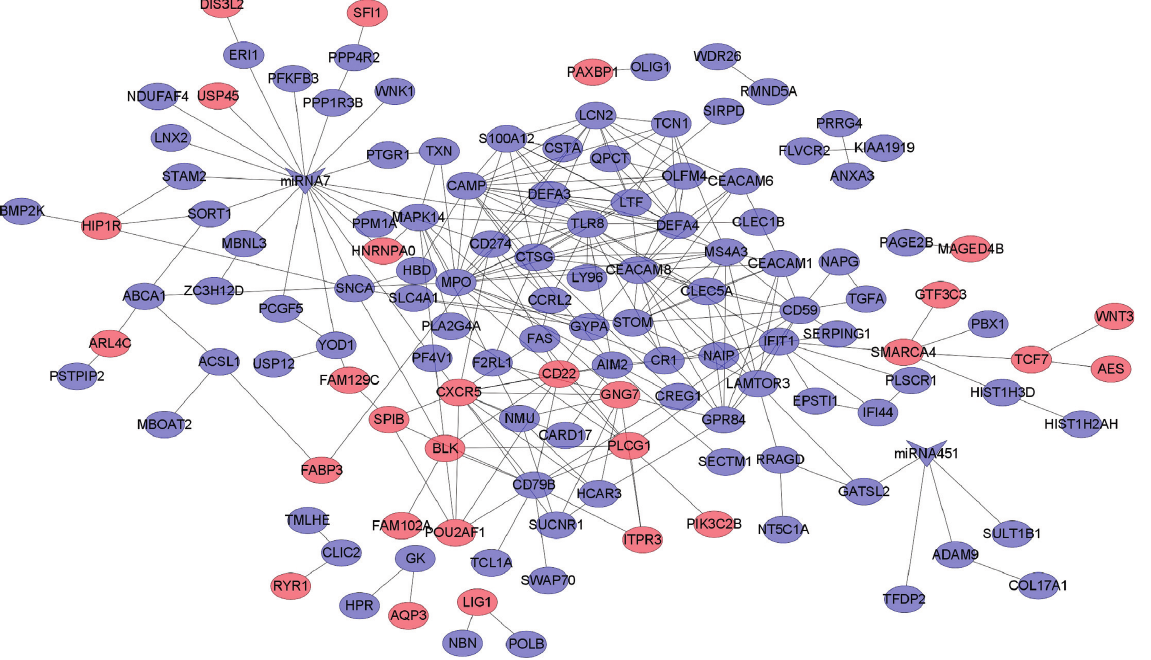
Figure 6: The PPI network of DEGs and DE miRNA. The blue nodes indicate the downregulated genes. The red nodes indicated the upregulated genes. The blue V-shape nodes stand for downregulated miRNA.